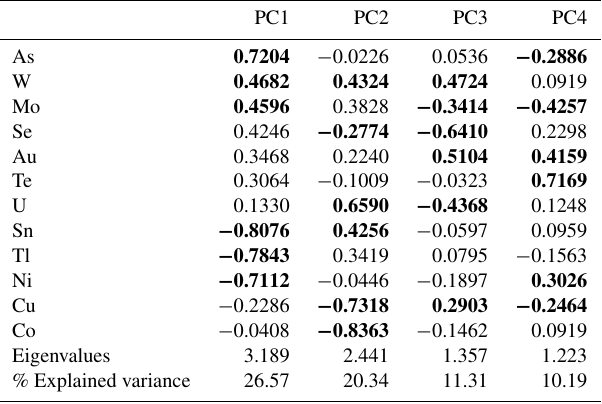
Table 2. Results from principal component analysis from the n = 1084 whole-rock geochemical data, including the 12 variables in re- lation to the first four principal components, which contain most of the data variance (see corresponding eigenvalues). The proportion of the variance in each eigenvector is displayed as the percentage of the explained variance. The first three elements with the largest positive and negative loadings along the positive and negative axis of each PC are marked in bold print.